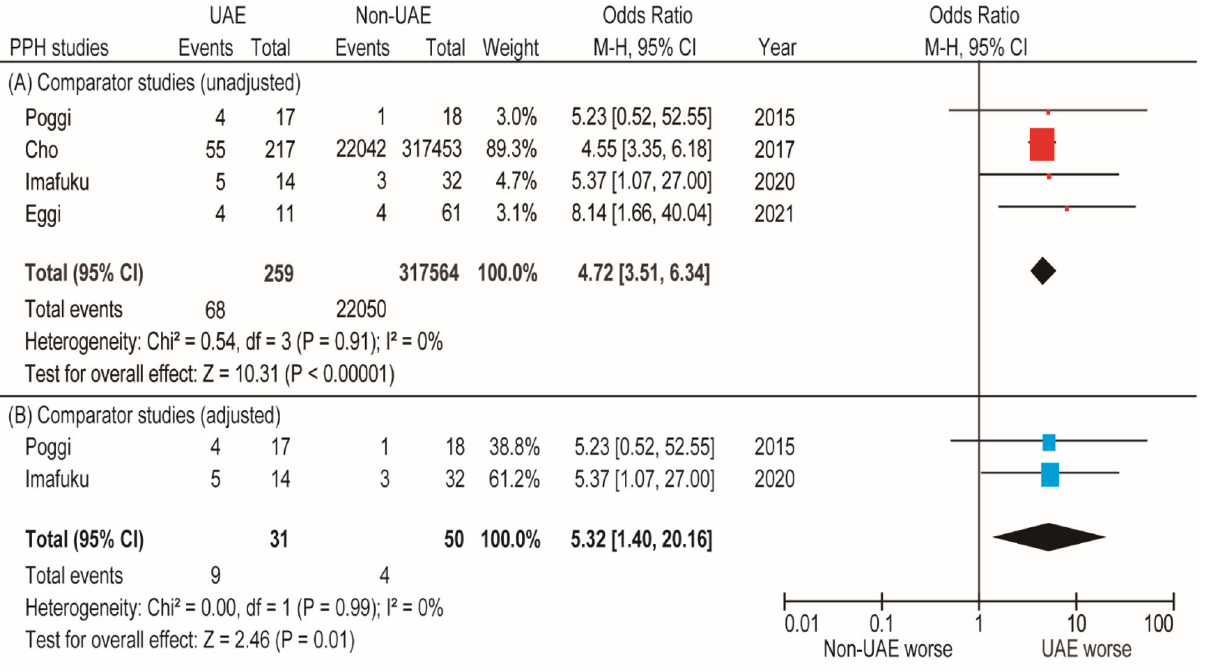
Figure 4. Results of the meta-analysis of the effect of prior UAE on the rate of PPH. The pooled odds ratio of ( A ) PPH and ( B ) PPH with previous PPH for women who did and did not undergo prior UAE. Some values listed might be slightly different from the original values because the calculation was performed using Revman ver. 5.4.1. PPH postpartum hemorrhage, UAE uterine artery embolization, CI confidence interval, df degrees of